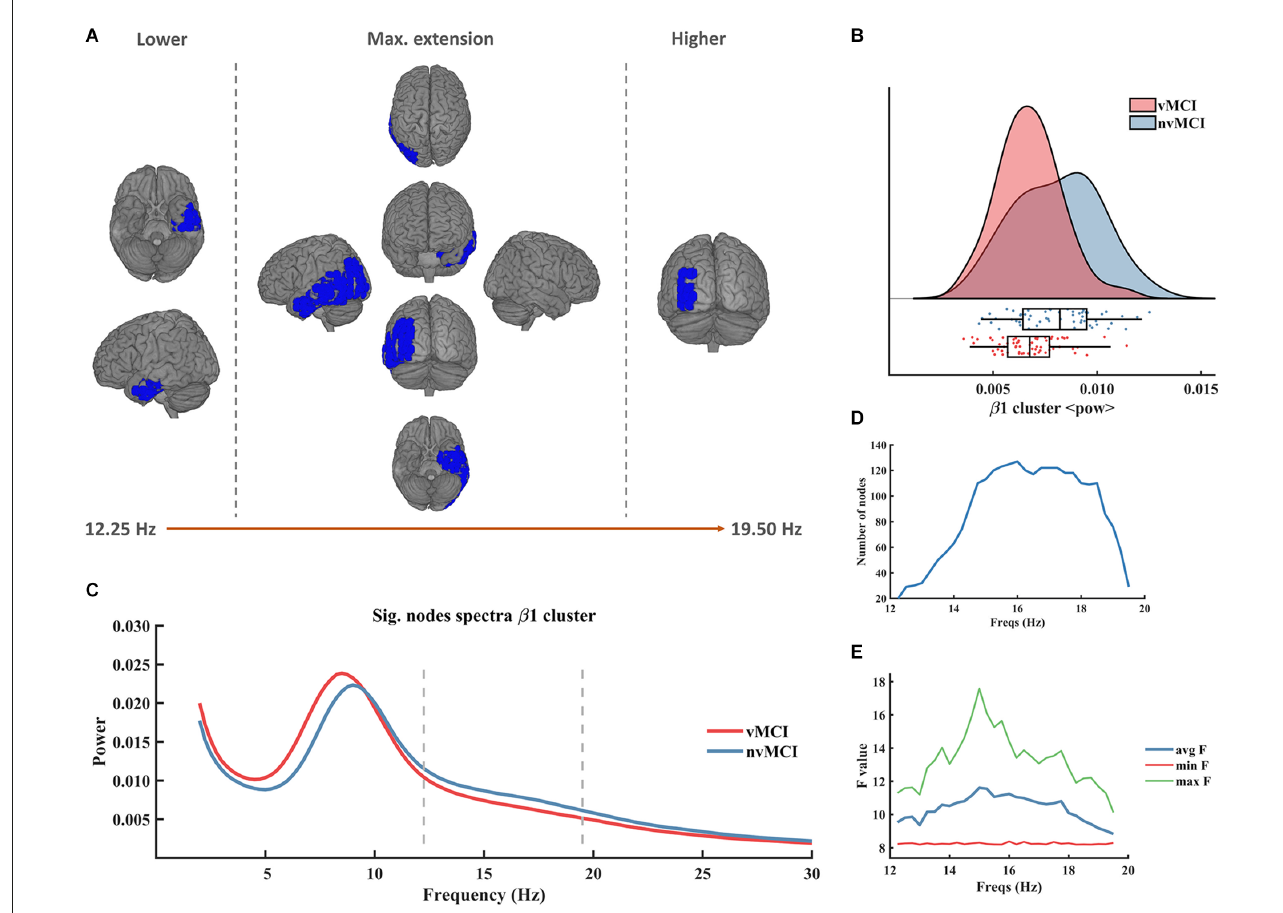
FIGURE2 Significant result found within the beta frequency range in the left temporo-parietal region. (A) Description of the regions involved in the β 1 cluster. The cluster was found to be significant between 12.25 Hz and 19.50 Hz. In the figure can be seen the initial, final, and maximum extensions of the cluster. (B) Violin plots and boxplots graphics describing the individual values for the average power of the cluster in the significant frequency range. (C) Representation of the average spectral power across all significant nodes. The significant frequency region is marked with dashes lines. (D) Number of grid nodes that are part of the cluster at each frequency step (maximum extension was found at 16 Hz). (E) Minimum, maximum, and average F values across all nodes contained within the cluster at each frequency step.